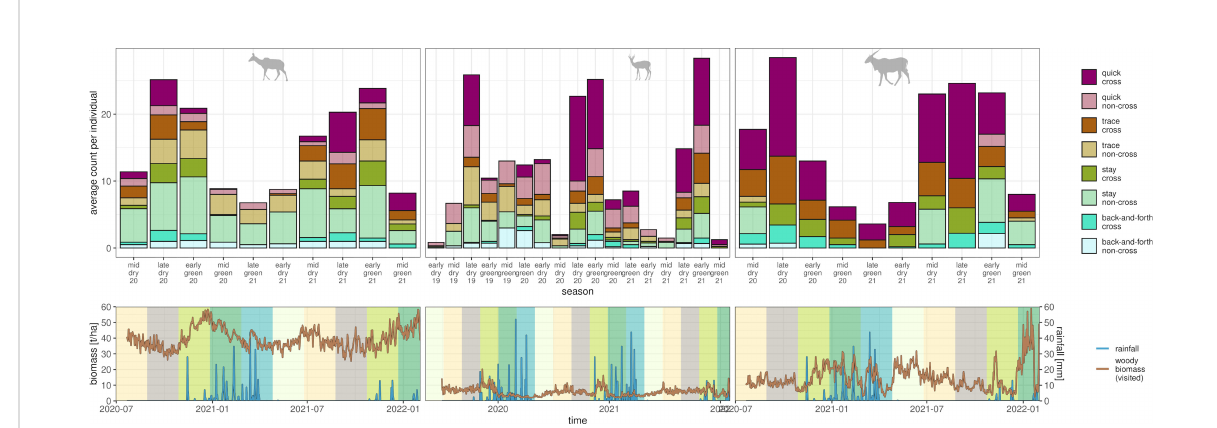
FIGURE 5 Temporal peaks in numbers of fence interactions along seasons and in relation to environmental conditions. Upper row of panels shows species-wise (panels, see icon) and interaction-type speci fi c (see legend) counts of identi fi ed interactions per season (60-day periods). Counts were averaged by the number of observed individuals per season. Lower row of panels shows daily precipitation (blue lines) and daily average of above-ground woody biomass of the locations that were visited by all individuals of a species (brown line). Low values of woody biomass indicate open habitats, high values indicate shrub and woodlands. Colored rectangles in background depict the corresponding season used for the analysis in the upper row of panels. Note that for the last season (mid green 21), tracking data were available for a few individuals